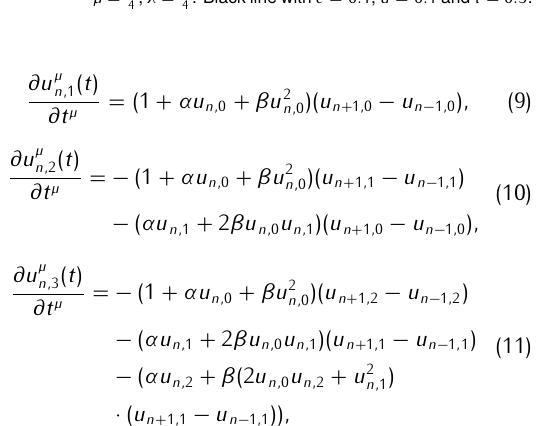
( n,t ) as in Eq. , λ = 1 . Green line 2 2